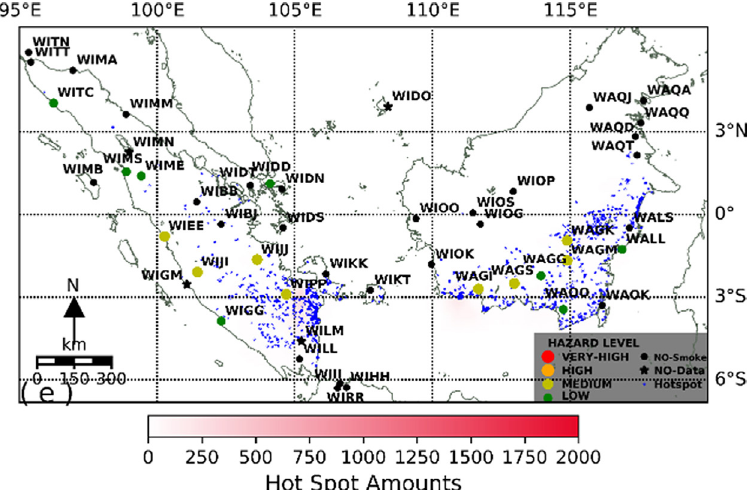
Fig. 4 e. The same as Fig. 4 a, for Month November 2015.